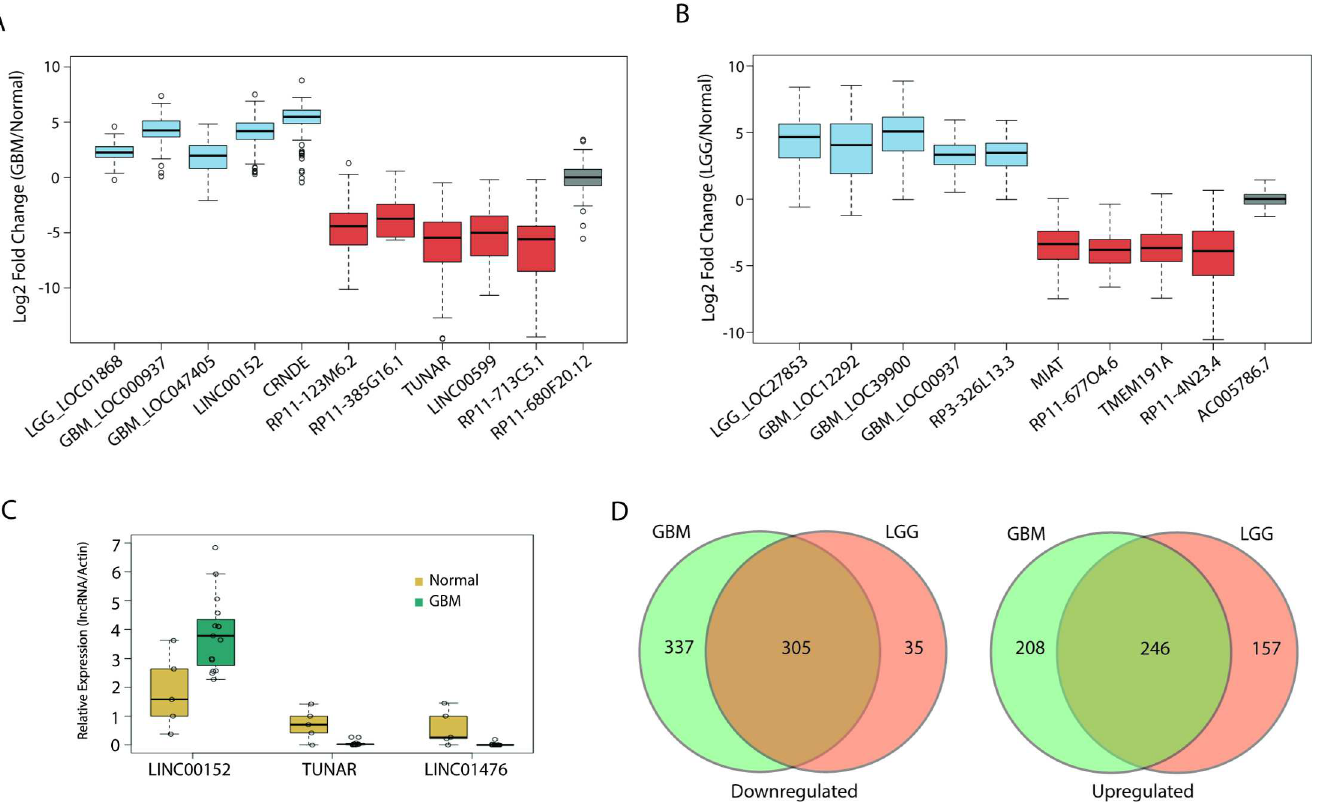
Fig 2. Large alterations in lncRNA expression in glial tumors. (A) Boxplot of ten candidatelncRNAs that are differentiallyexpressedin GBMs comparedto normaltissue (blue = upregulated, red = downregulated, grey = no change). (B) Boxplot of nine candidate lncRNAs that are differentially expressedin LGGs comparedto normaltissue (blue = upregulated, red = downregulated, grey = no change). (C) Real-timePCR of LINC00152, LINC01476, and TUNAR in 15 GBM and five normal brain samples confirms upregulation of LINC00152and downregulation of LINC01476 and TUNAR in GBMs comparedto normal brain. Expression values for each lncRNAare normalizedto that of the gene encoding actin. (D) Large overlap in differentially expressedlncRNAs betweenGBMs and LGGs. GBM, glioblastoma multiforme; LGG, lower grade glioma; lncRNA, long noncodingRNA.